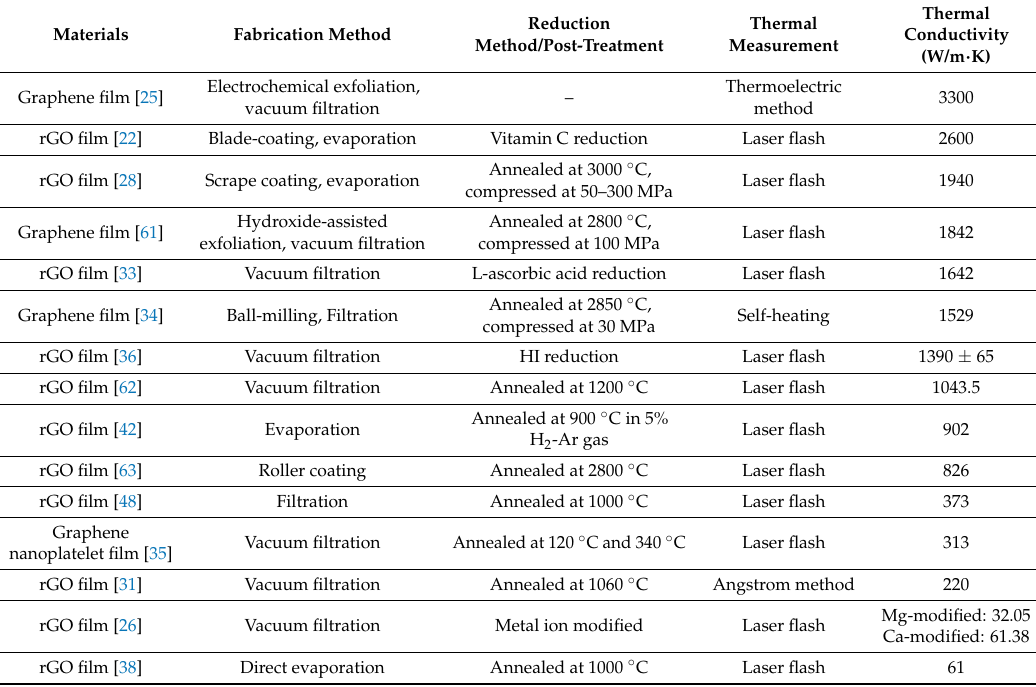
Table 1. Summary of the GFs obtained from different synthesis